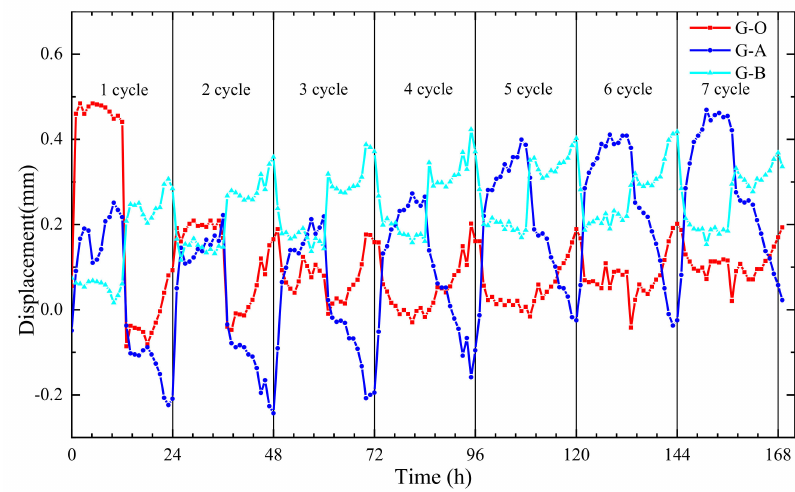
Figure 10. Process and duration curve of salt-frost heave of saline soil at different